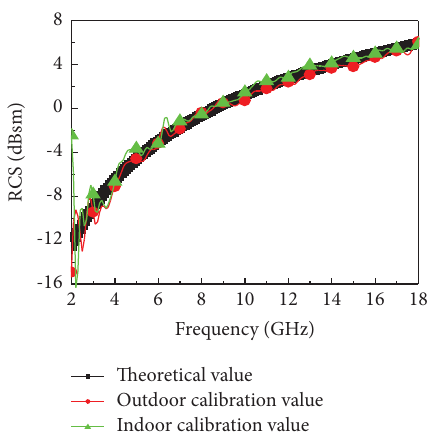
Figure 9: Metal plate RCS measurement